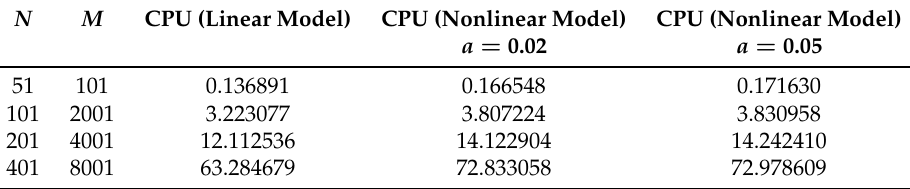
Table 4. CPU time